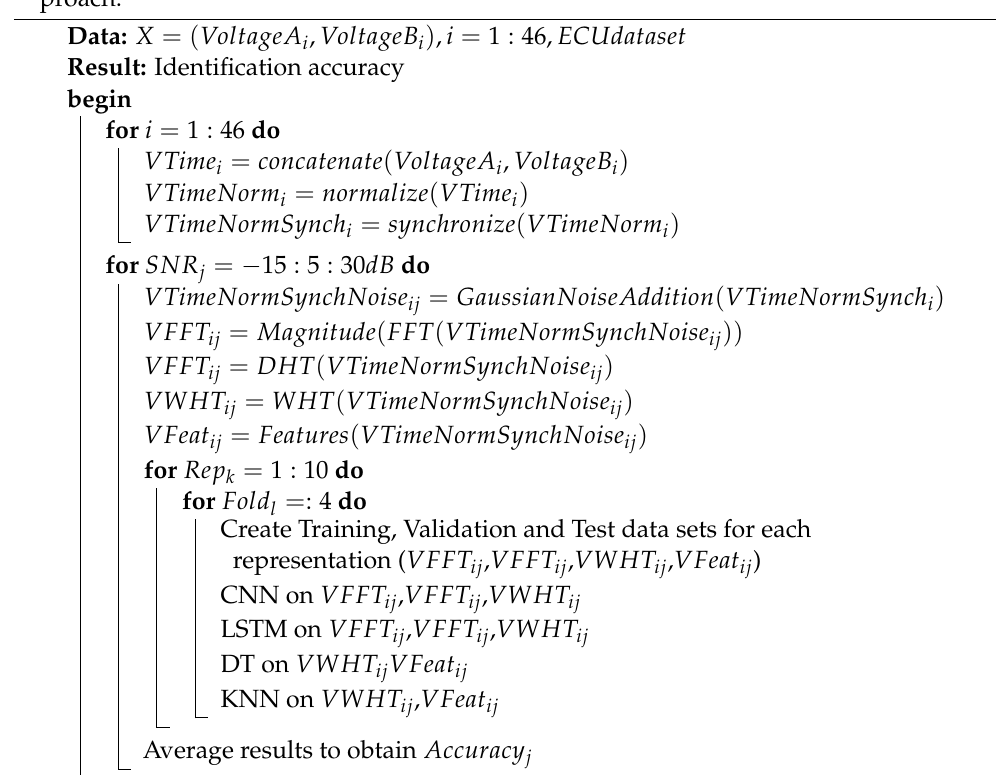
Algorithm 1: Algorithmic representation of the workflow of the proposed ap-